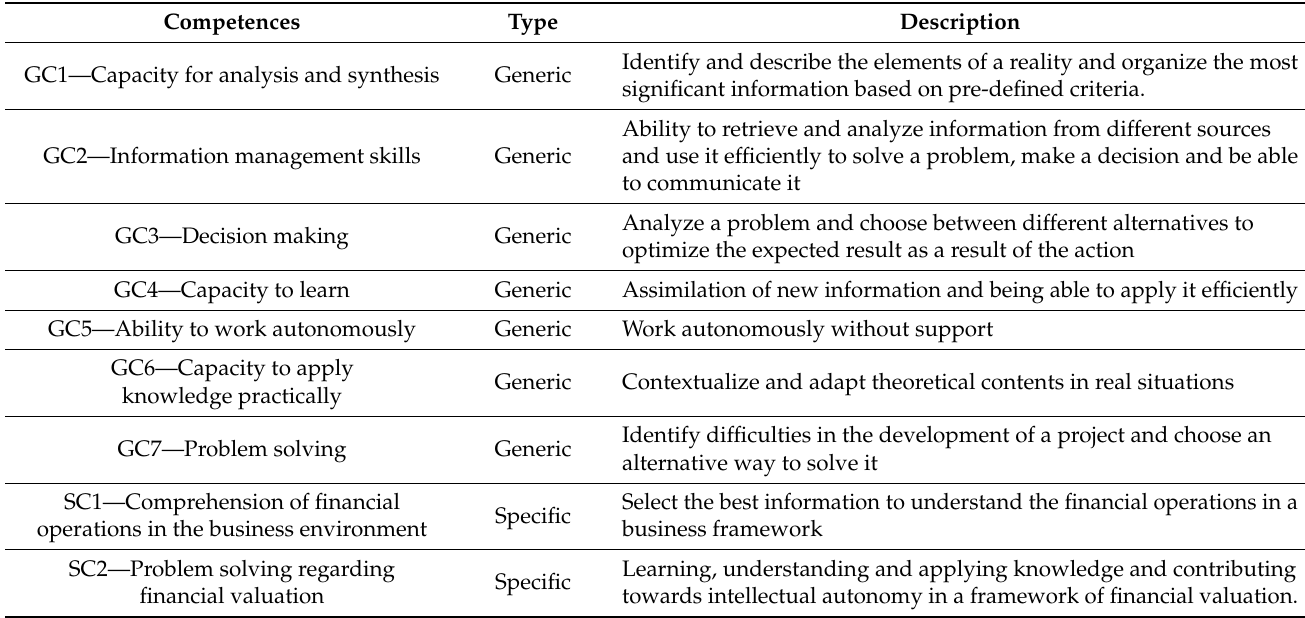
Table 2. Generic and subject specific competences (based on [26]).